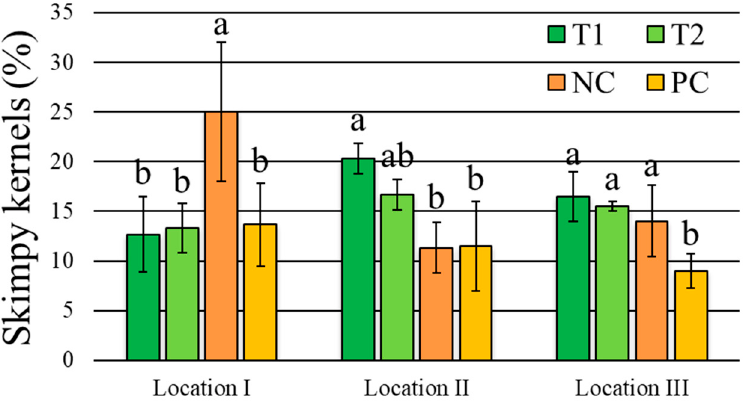
Figure 7. Location × treatment interaction derived from two-way analysis of variance (ANOVA) on durum wheat grain skimpy kernels. Bars represent the standard deviations ( n = 4). Different letters indicate statistical signi fi cance at p ≤ 0.05 (Fisher’s LSD test). T1: DiS-NH 2 at a standard dosage (0.75 g m − 2 ); T2: DiS-NH 2 at a double dosage (0.75 g m − 2 ); NC: negative control (no weeding); PC: positive control (chemical weeding).